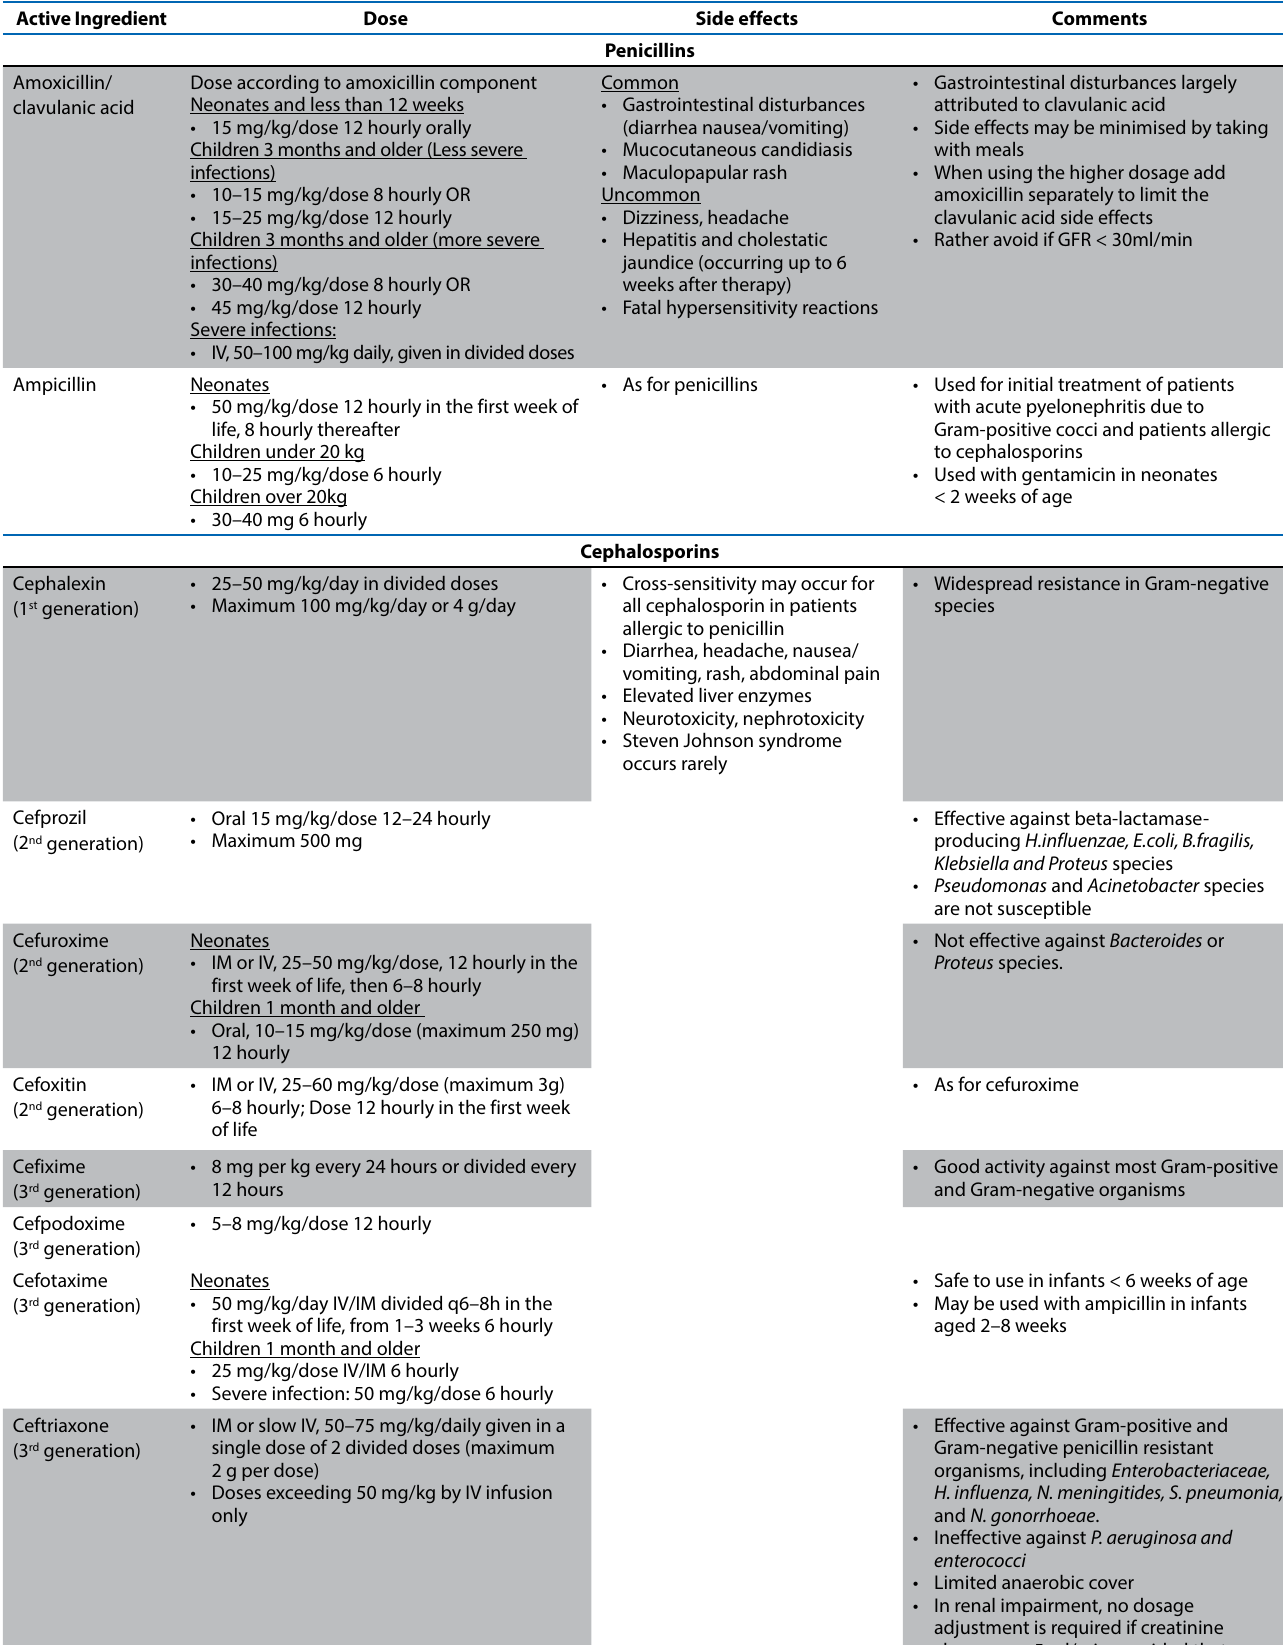
Table 1. Antibiotics used to treat UTIs in children Active